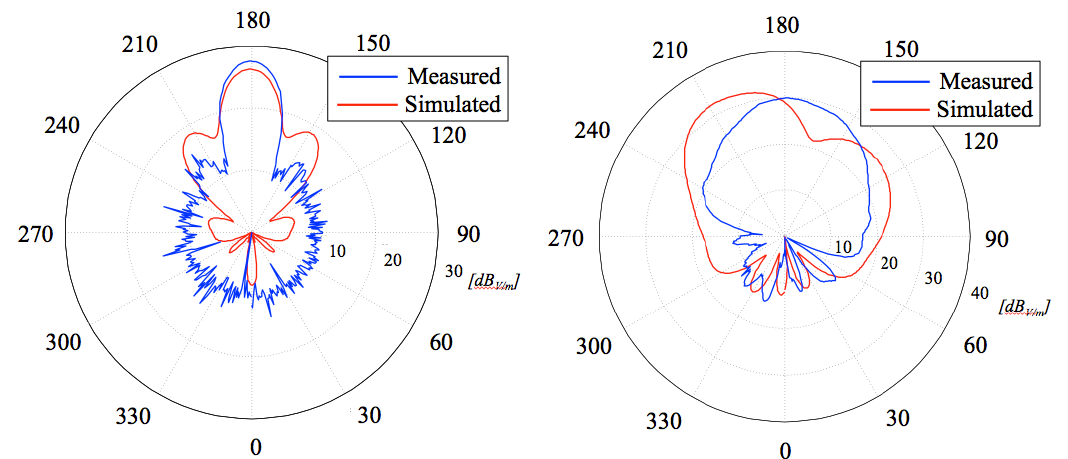
Figure 12. Radiation patterns of the receiving patch antenna over both horizontal ( Left ) and vertical ( Right ) planes: a comparison between calculated and measured